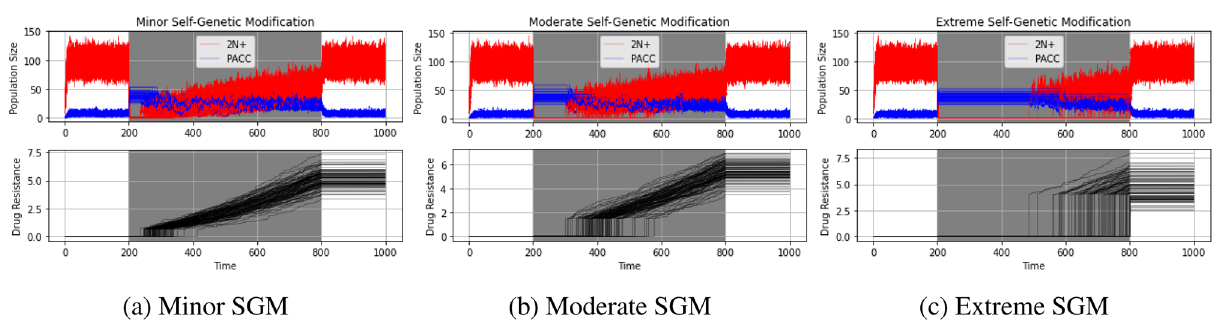
Figure 5. Population and strategy dynamics for self-genetic modification under continuous therapy. The degree of self-genetic modification influences when the cancer cell population shifts from self-genetic modification to evolutionary triage: the greater the degree of self-genetic modification, the longer the cells will remain in a stable PACC